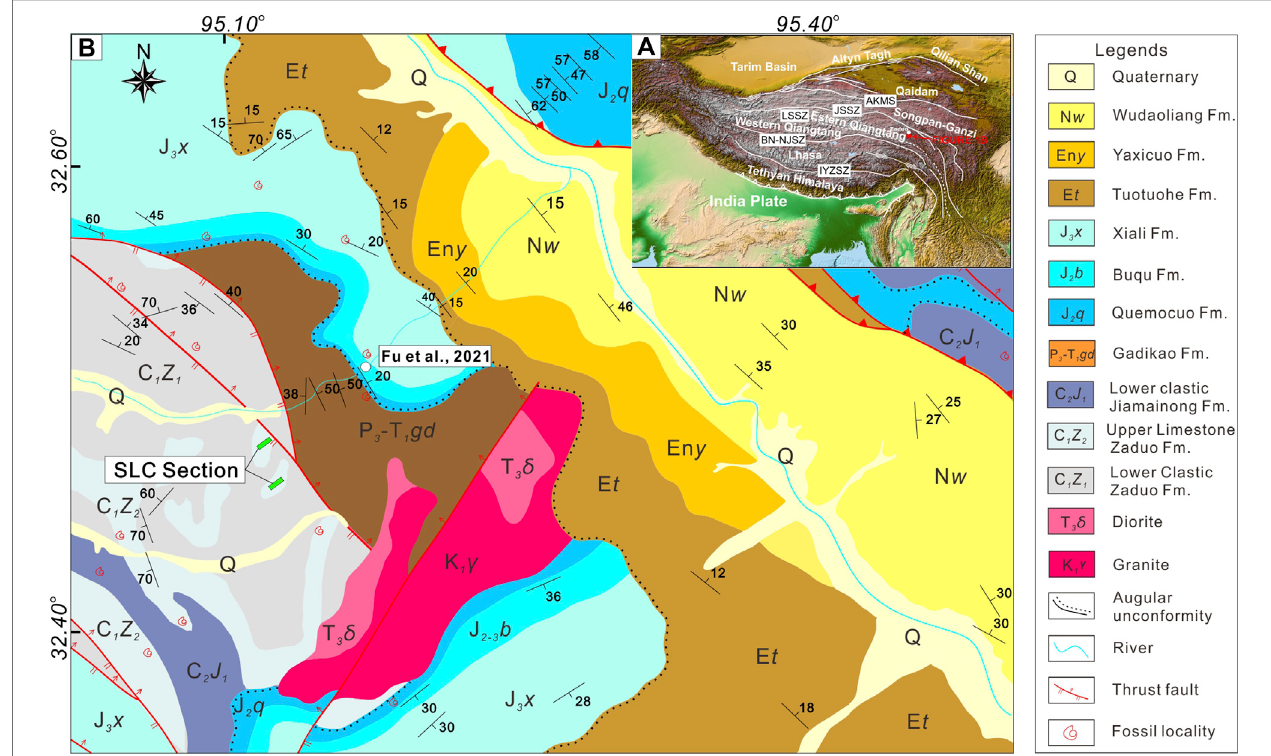
FIGURE1|(A) Simpli fi edtectonic mapoftheTibetanPlateauand itsadjacentregions, showingthelocationofZaduo (B) Detailed geologicmapoftheZaduoarea showing the location of the sampled Sulucun section in the green square (modi fi ed from the 1:250,000 Zaduo County regional geological map (I46C004004) by the Qinghai Geological Survey Institute (QGSI), 2005b). Abbreviations in (A) : AKMS, Ayimaqing – Kunlun – Muztagh suture zone; BG-NJSZ, Bangong – Nujiang suture zone; IYZSZ, Indus – Yarlung Zangbo suture zone; JSSZ, Jinshajiang suture zone; LSSZ, Longmu Tso – Shuanghu suture zone. The circles in (B) represent the previous remagnetization study from Fu et al.